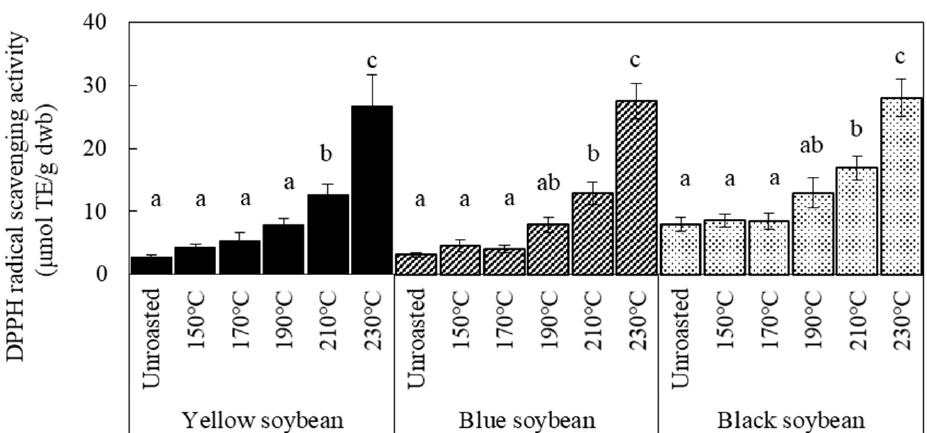
Figure 1. Effect of roasting temperatures on DPPH radical scavenging activity. Sample soybeans were stored at 4 °C. Significant differences within the same bean are indicated by lowercase letters a, b, and c. p < 0.05. n = 3.